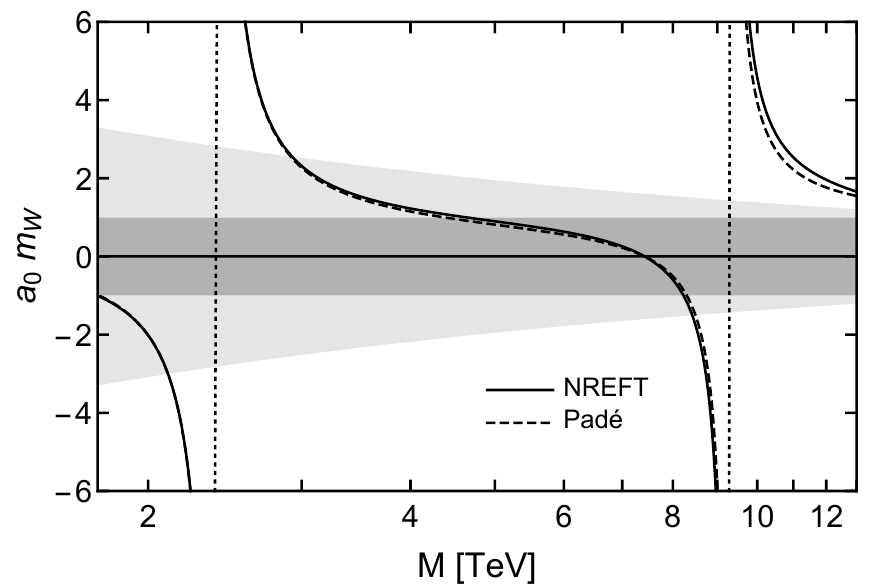
Figure 4 . The neutral-wino scattering length a 0 as a function of the wino mass M (solid curve). The dashed curve is the Pad(cid:19)e approximant given in eq. (3.13). The vertical dotted lines indicate the (cid:12)rst and second unitarity masses M (cid:3) = 2 : 39 TeV and 9.23 TeV. If a 0 is outside the darker shaded region ( j a 0 j < 1 =m W ), a zero-range e(cid:11)ective (cid:12)eld theory for winos is applicable. If a 0 is outside the p lighter shaded region ( j a 0 j < 1 = 2 M(cid:14) ), a zero-range e(cid:11)ective (cid:12)eld theory for neutral winos only is